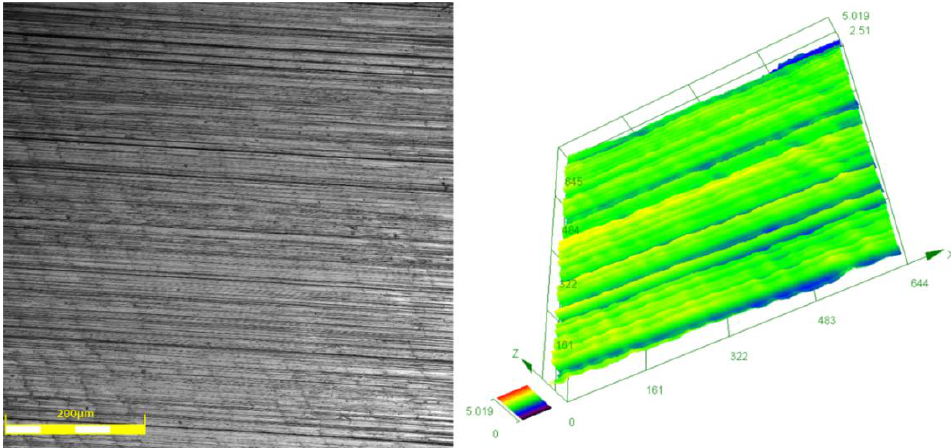
Figure 29. The milled surface of titanium alloy TC21 with optimized parameters.